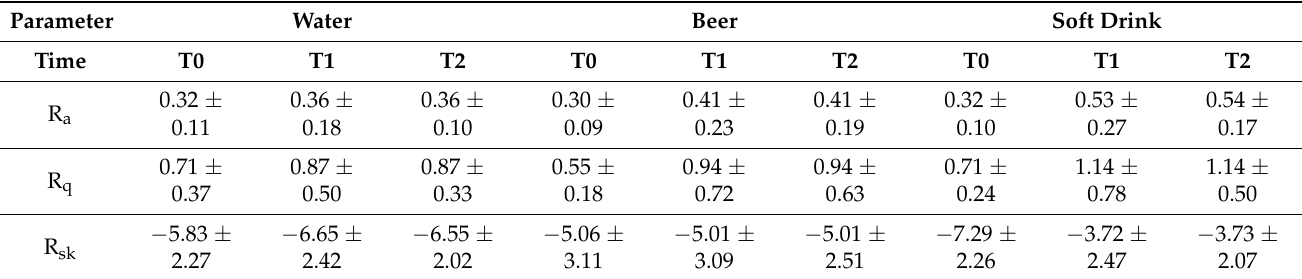
Table 5. Results regarding roughness of glass ionomer specimens.